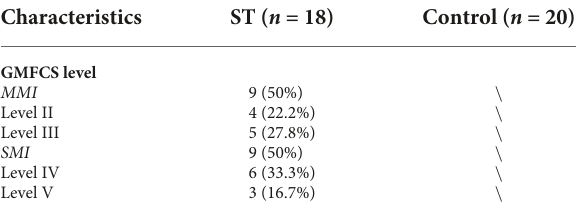
TABLE 2 Classification of the gross motor function in children with spastic CP. Characteristics